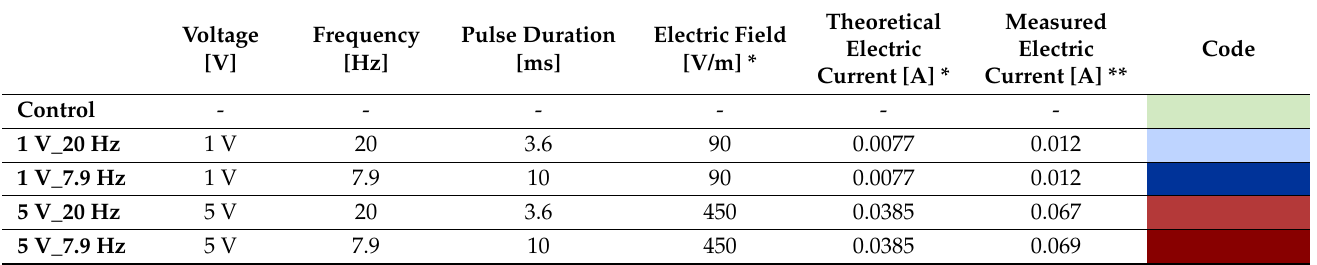
Table 1. Individual ES values after measurement and simulation. To each setup, appropriate colors were dedicated (Code).